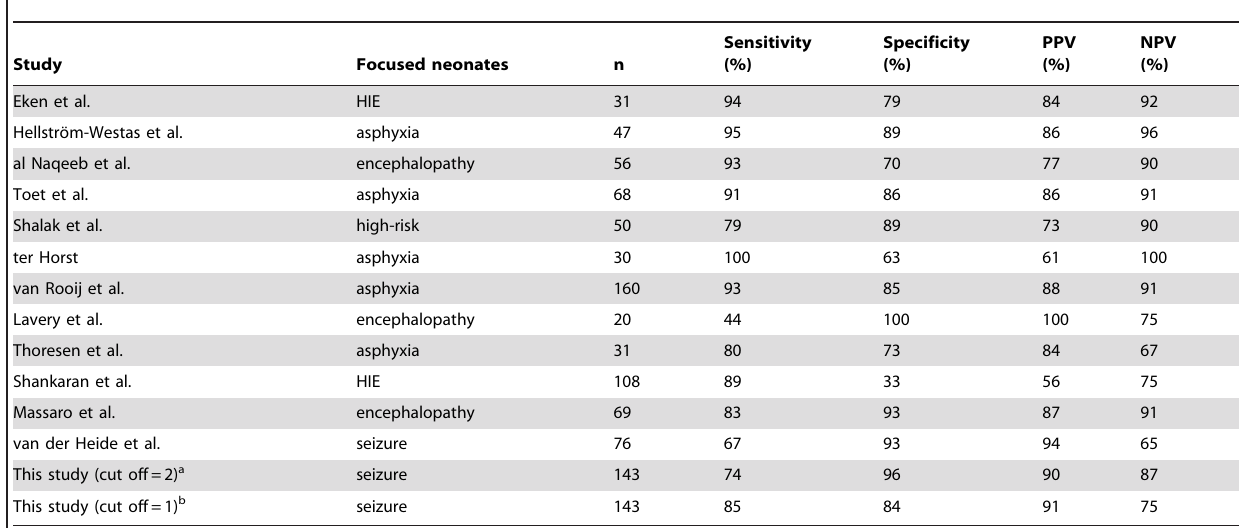
Table 7. Full-term neonatal studies on the predictive value of early abnormal aEEG background pattern for subsequent abnormal outcome (listed in time